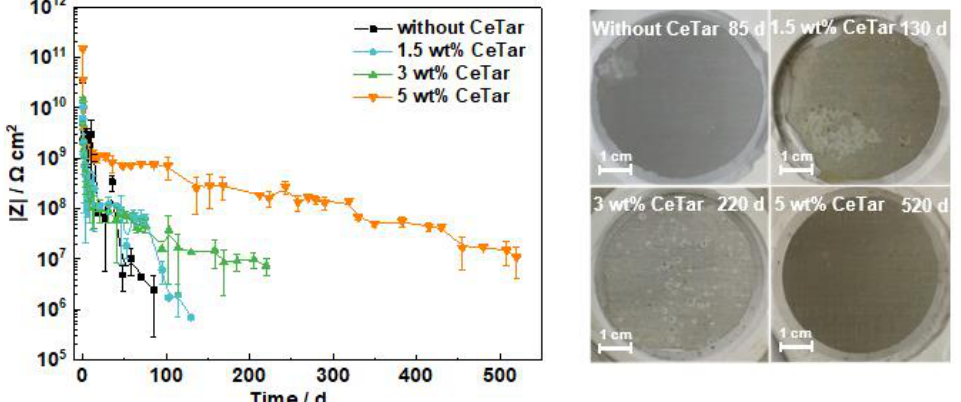
Figure 5. Variation of | Z | 0.01 Hz with time for the coated samples with different contents of CeTar and morphology photos of the coatings with different contents of CeTar.